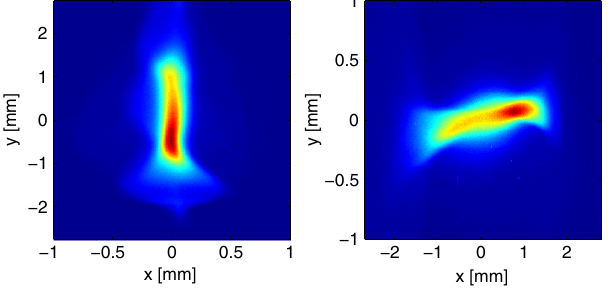
FIG. 7. Example of a streaked beam using dispersion in the vertical direction (left plot) and in the horizontal plane (right plot).